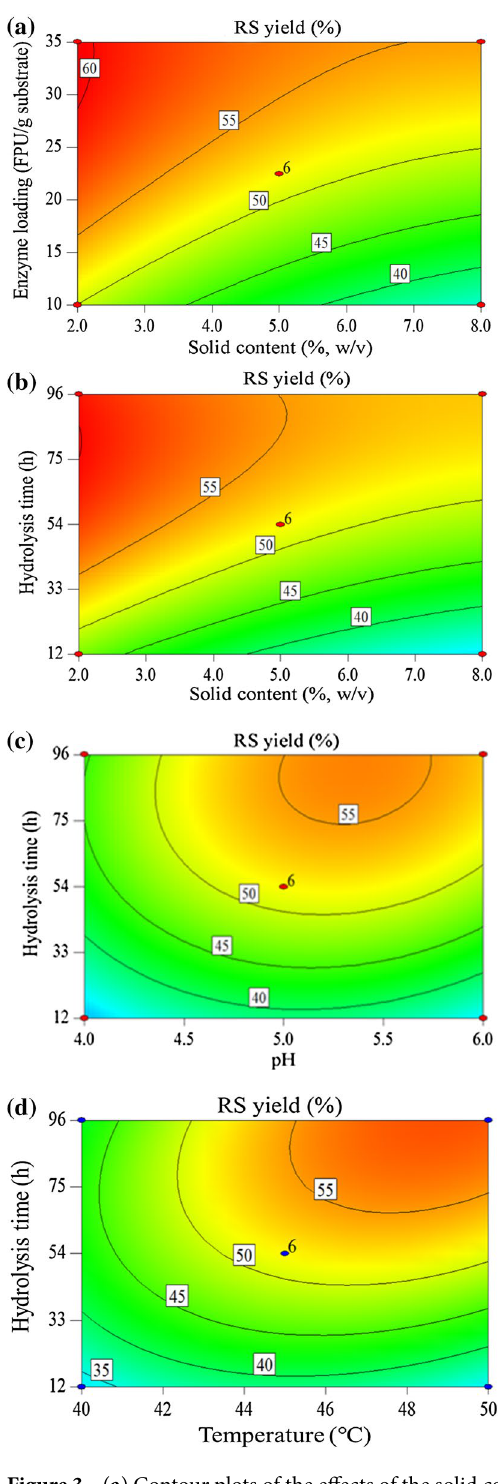
Figure 3. ( a ) Contour plots of the effects of the solid content and enzyme loading on the RS yield at an initial temperature of 45 °C, pH value of 5.0 and hydrolysis time of 54 h. ( b ) Contour plots of the effects of the solid content and hydrolysis time on the RS yield with an enzyme loading of 22.5 FPU/g substrate, a temperature of 45 °C and a pH value of 5.0. ( c ) Contour plots of the effects of the pH and hydrolysis time on the RS yield at an initial solid content of 5.0% (w/v), an enzyme loading of 22.5 FPU/g substrate and a temperature of 45 °C. ( d ) Contour plots of the effects of the temperature and hydrolysis time on the RS yield at an initial solid content of 5.0% (w/v), an enzyme loading of 22.5 FPU/g substrate and a pH value of